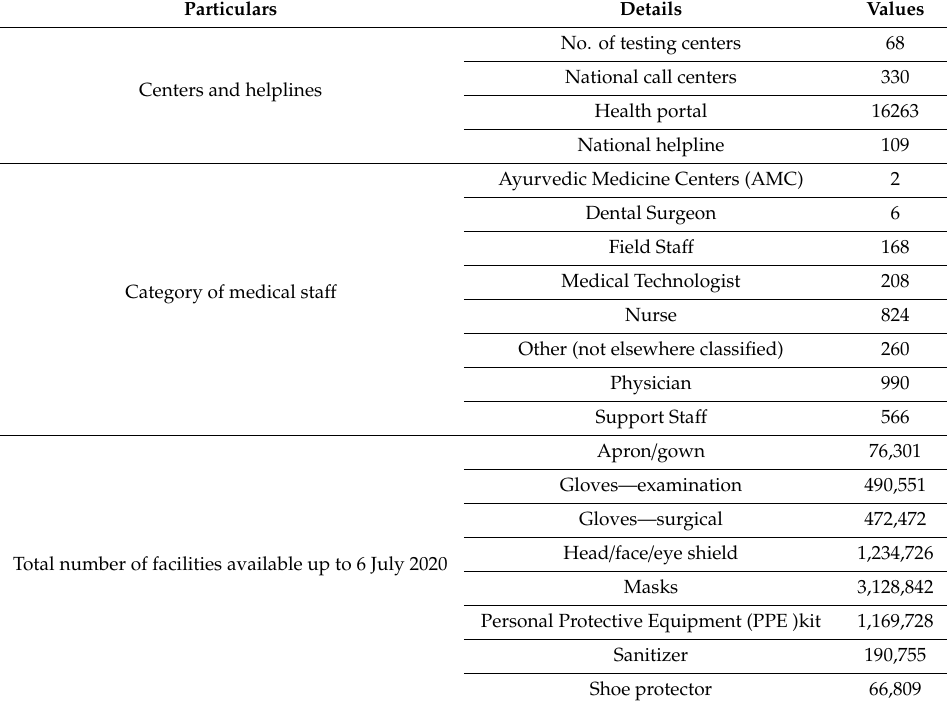
Table 1. Service facilities for mitigating